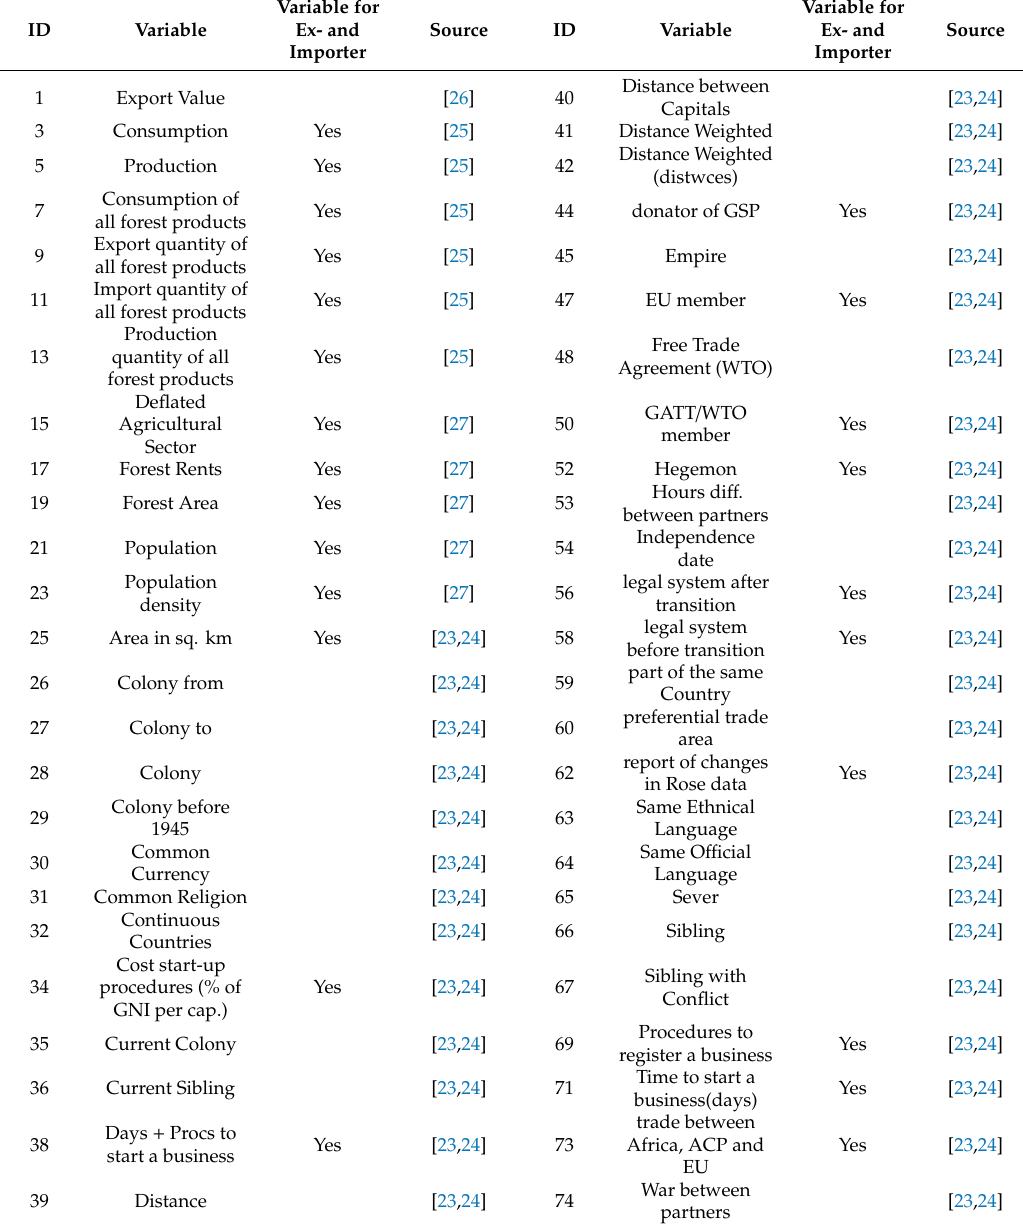
Table A1. Total variable